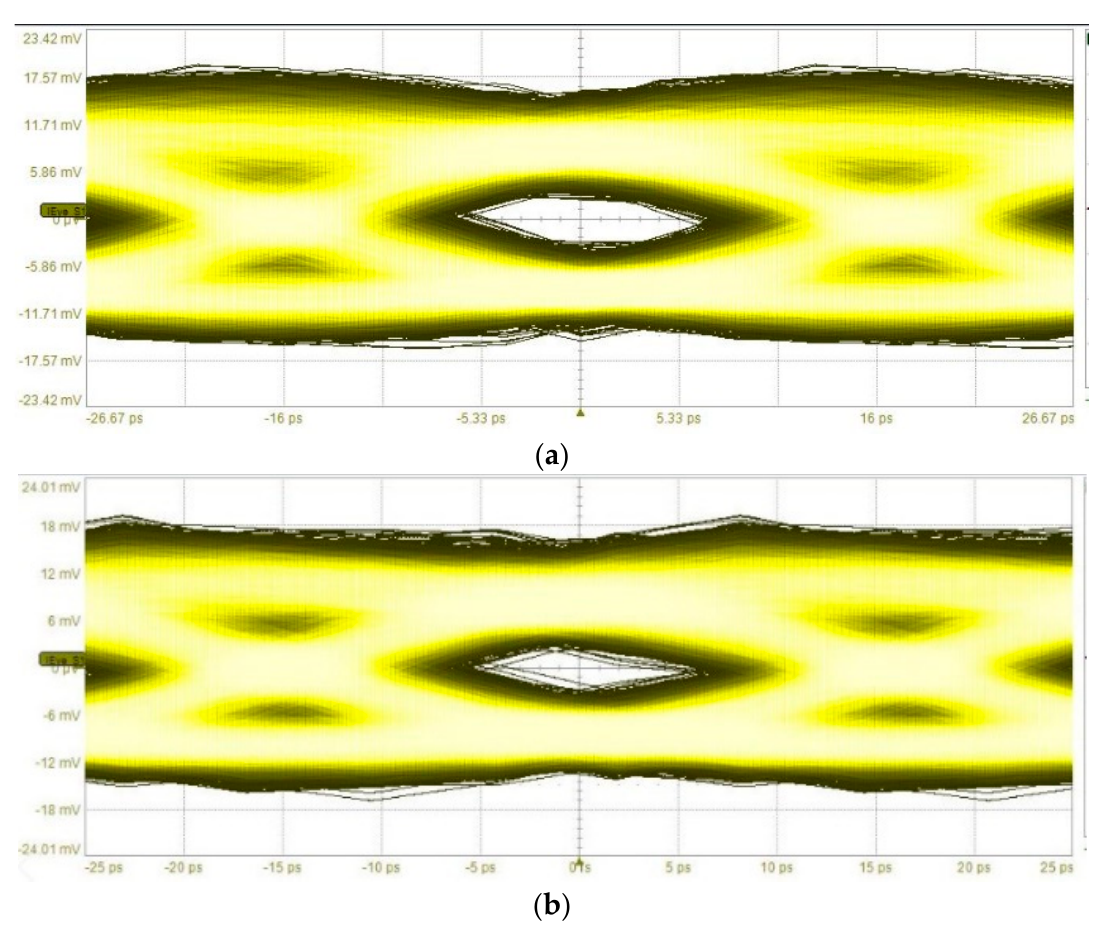
Figure 17. Eye diagrams from the demodulated PAM-2 signal at 130.6 GHz. ( a ) 30 Gbps signal. BER < × 10 − 12 . ( b ) 32 Gbps signal. BER = 2.6 × 10 − 10 . Table 1. Link budget: carrier frequency at 131 GHz.